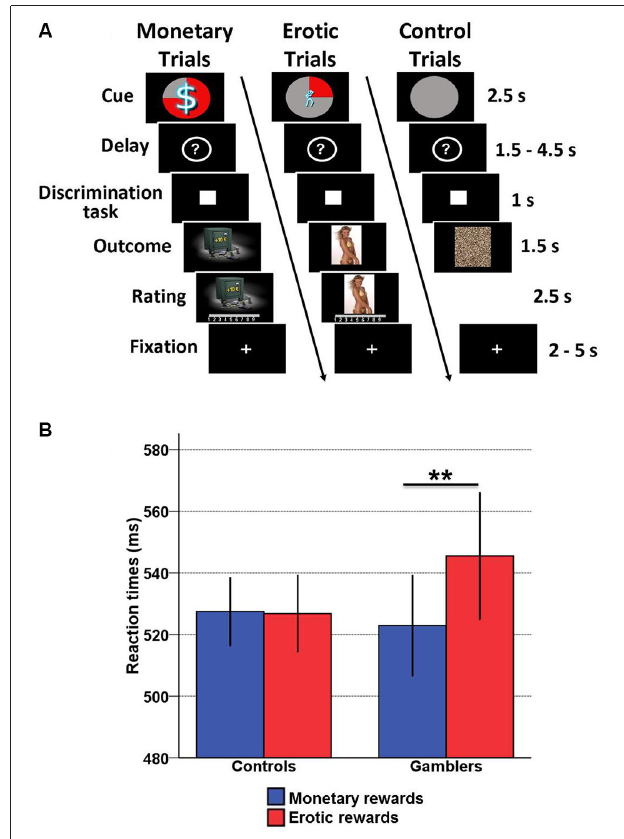
FIGURE 1 | Incentive delay task and behavioral results. (A) Subjects first saw a cue informing them about the type (pictogram), intensity (size of pictogram) and probability (pie chart) of an upcoming reward. Three cases are represented here: a 75% chance of receiving a large amount of money (left), a 25% chance of seeing a low erotic content picture (middle) and a sure chance of getting nothing (control trials, right). Then the cue was replaced by a question mark, symbolizing a delay period during which a pseudorandom draw was performed according to the announced probability. Following this anticipation phase, participants had to perform a target discrimination task within <1 s. The target was either a triangle (left button press required) or a square (right button press required). Both their performance and the result of the pseudorandom draw determined the nature of the outcome. In rewarded trials, subjects saw a monetary amount displayed on a safe (high or low amount, left) or an erotic picture (with high or low erotic content, middle), and had to provide a hedonic rating on a continuous scale. In non-rewarded and control trials, subjects saw a scrambled picture (right). (B) Plot of mean reaction times according to reward type (monetary/erotic) and group (healthy controls/gamblers) in the discrimination task. There is a significant interaction between group and reward type, driven by slower reaction times for erotic compared to